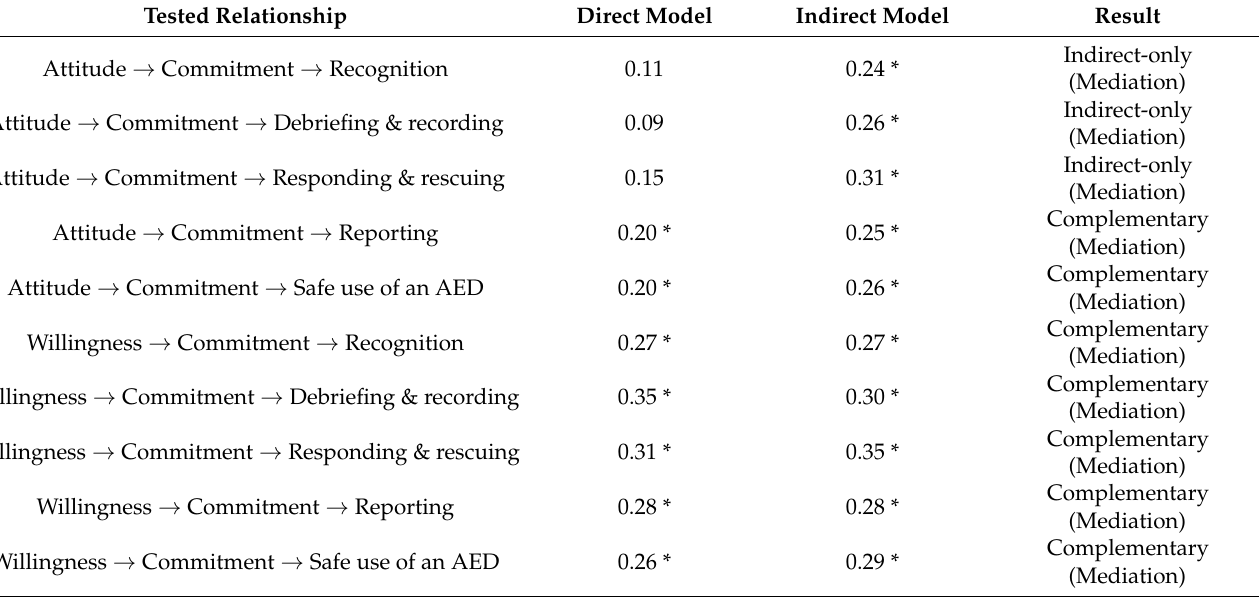
Table 7. Mediation